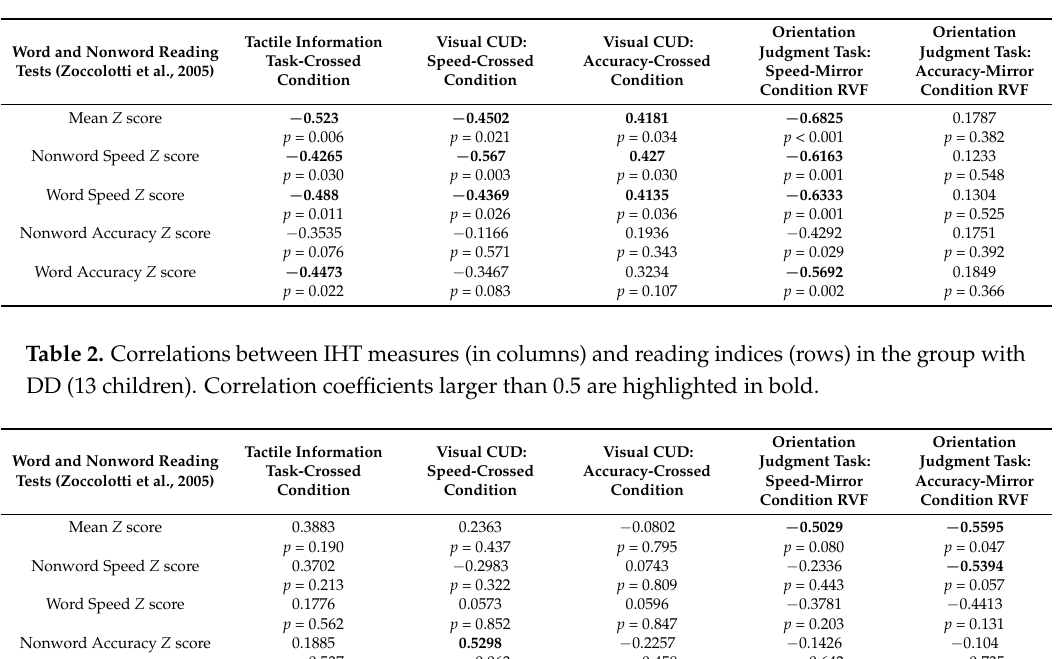
Table 1. Correlations between IHT measures (in columns) and reading indices (rows) in the whole sample (26 children). Correlation coefficients larger than 0.4 are highlighted in bold.